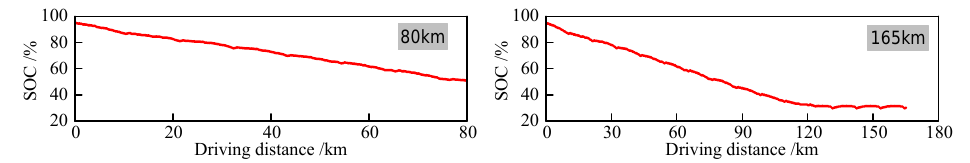
Fig. 8. Battery SOC variations of 120-km NN controller under different driving distances Figure 9. Battery SOC variations of the 120-km NN controller under different driving distances.